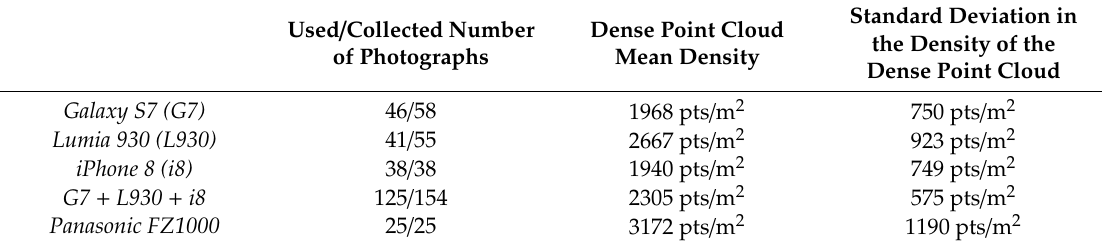
Table 2. Mean density and standard deviation obtained on the dense point clouds reconstructed from the di ff erent